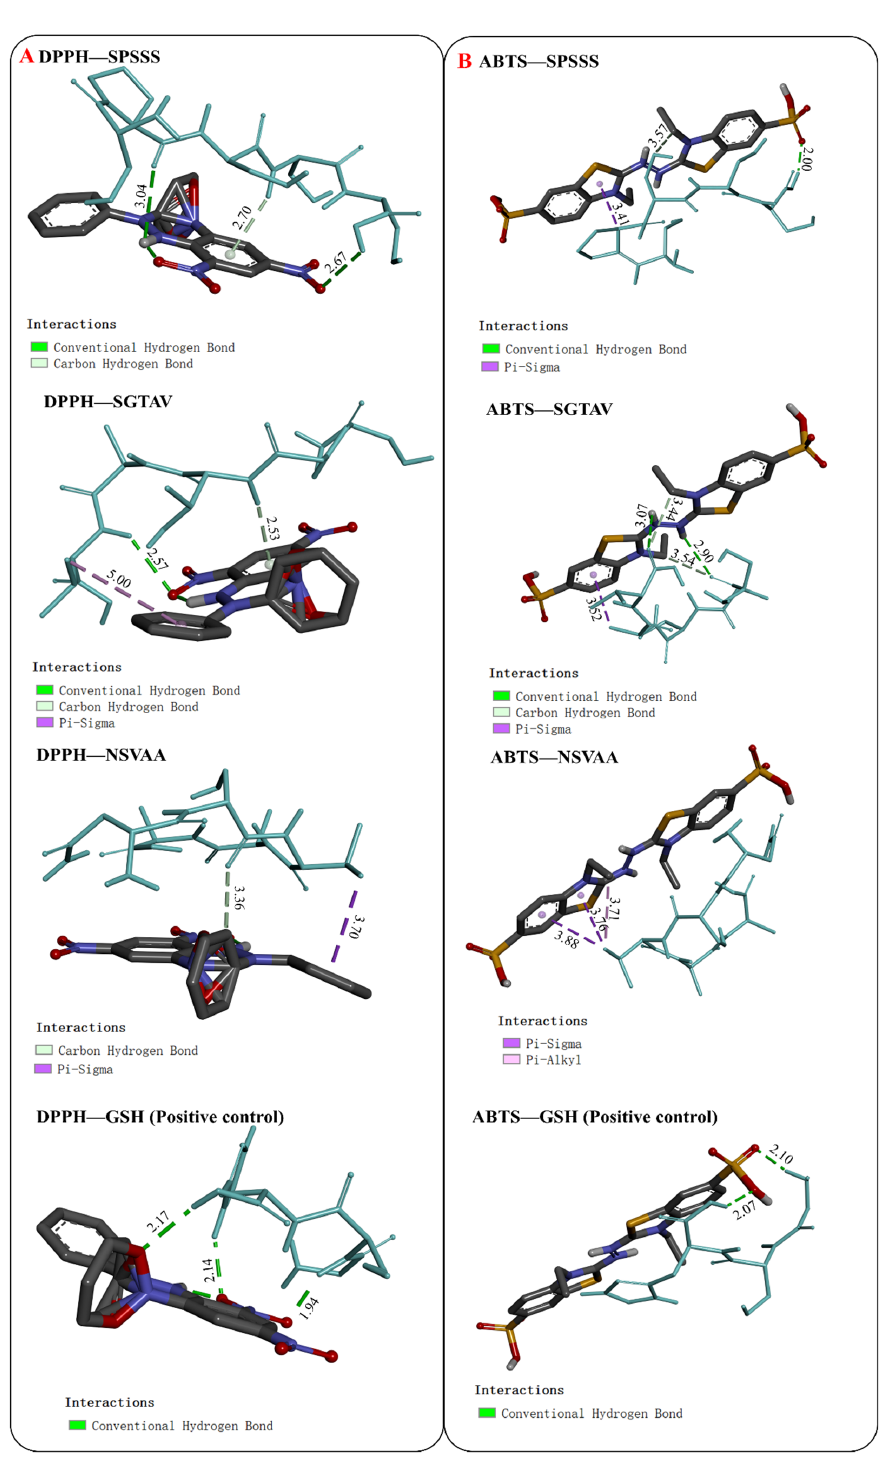
Figure 6. Visualization of molecular docking of antioxidant peptides SPSSS, SGTAV, and NSVAA and positive control (GSH) with free radical DPPH ( A ) and ABTS ( B ).